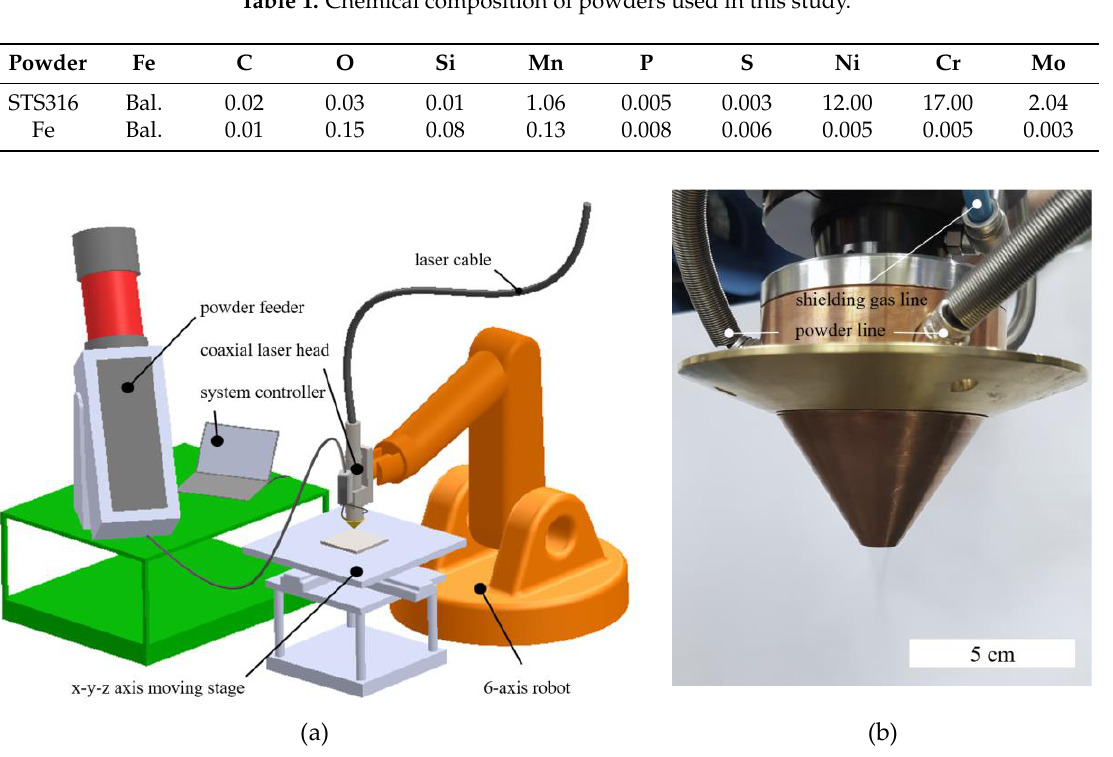
Figure 1. ( a ) Schematic diagram of experimental setup and ( b ) image of coaxial nozzle. Table 2. Various parameters for deposition used in this study.